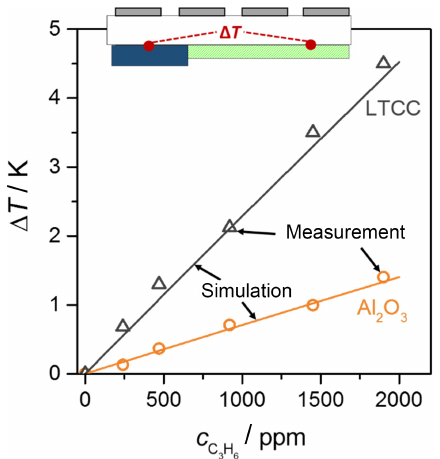
Figure 7. Measured (points) and simulated (lines) temperature dif- ference (cid:49)T between the catalytically activated and the inert part of the sensor when the propene feed gas concentrations and the sensor materials were varied (stationary conditions). The sensor temper- ature was kept constant at 600 ◦ C. The inset scheme illustrates at which points the temperature difference was evaluated.